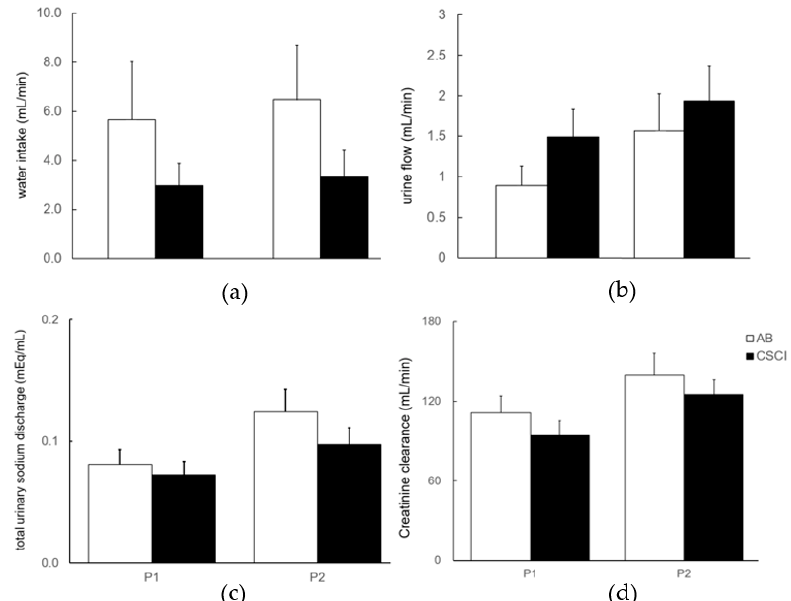
Figure 3. Water intake volume, urine flow, total urinary sodium discharge, and creatinine clearance at the two different time periods. Note the lack of statistically significant changes in the four parameters between the P1 and P2 periods. P1: time period from before the start of exercise to immediately after exercise, P2: time period from immediately after exercise to the end of the 60-min recovery period. Data are mean ± SEM. ( a ) shows water intake, ( b ) shows urine flow, ( c ) shows total urinary sodium, and ( d ) shows creatinine clearance.